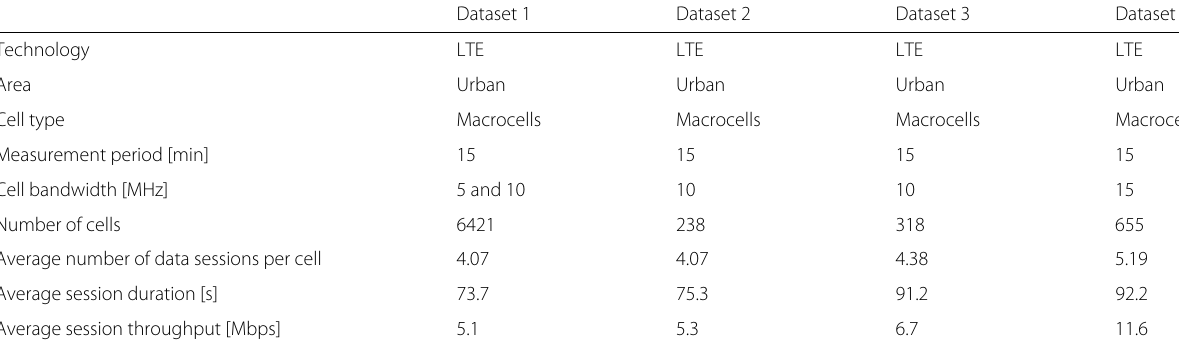
Table 1 Characteristics of the datasets and network-related